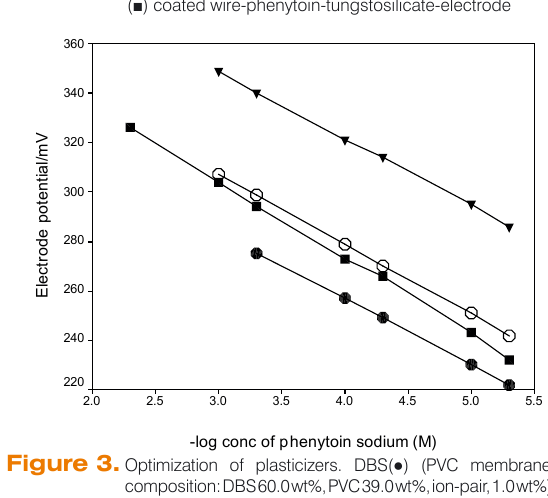
Figure 2. Typical calibration graph of phenytoin sodium sensors: ( ● ) phenytoin-tungstosilicate-plastic membrane electrode, ( ■ ) coated wire-phenytoin-tungstosilicate-electrode